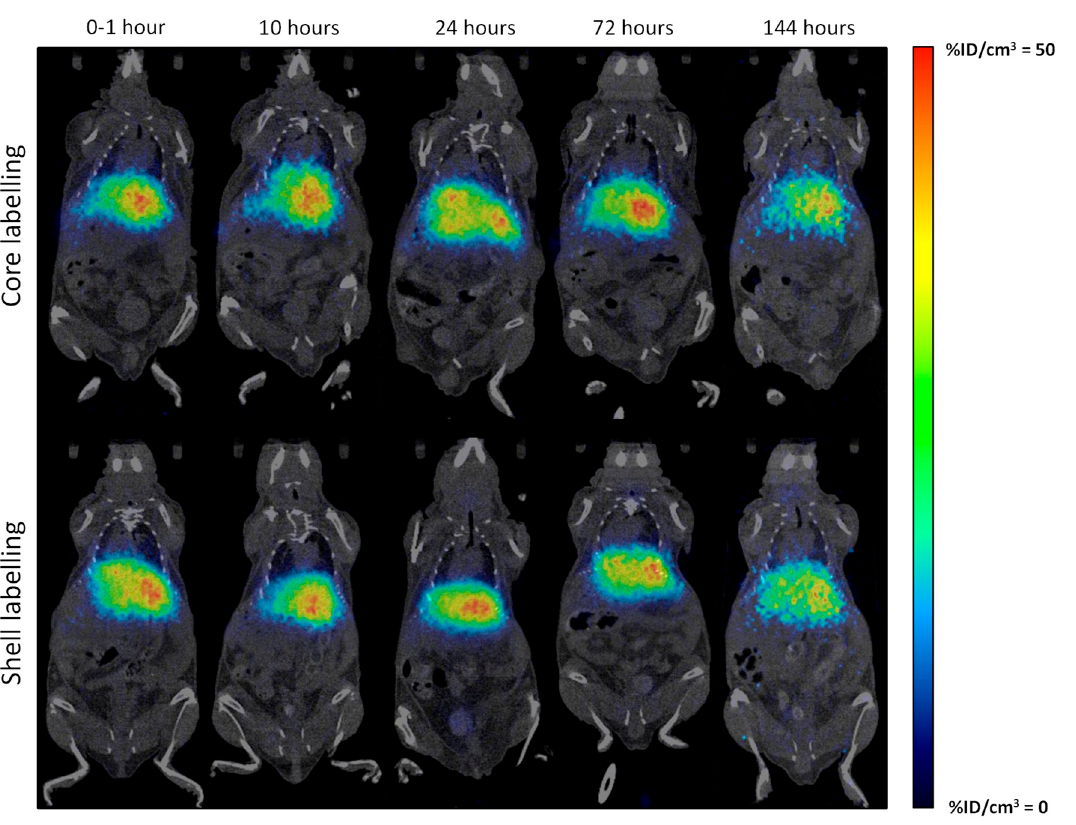
Figure 5. PET images (coronal projections) obtained at different time points after intravenous administration of [ 124 I]PEG-AuNPs@[ 4 ] − labelled at the core (top) and at the shell (bottom). PET images have been coregistered with representative CT slices for localization of the radioactive signal. The image labelled as “0–1 h” corresponds to the image obtained immediately after administration of the labelled NPs (imaging time = 1 h). Values expressed as %ID/cm 3 .